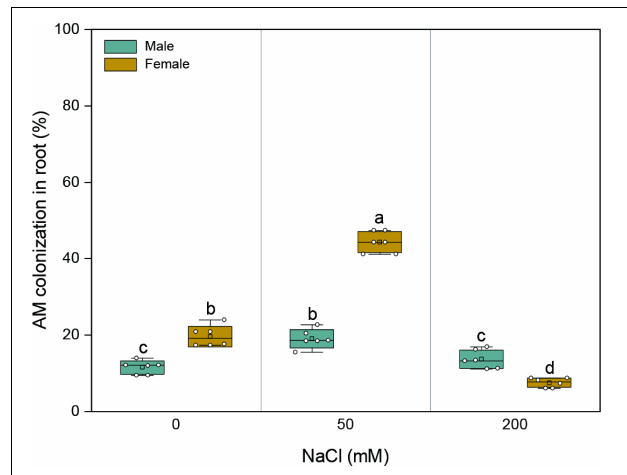
FIGURE 1 | Arbuscular mycorrhizal colonization of roots in about 7-month-old males and females of Morus alba inoculated with Funneliformis mosseae after 132 days of salinity treatment. Values are presented as means ± SD ( n = 6). Two-way ANOVA is performed to compare the effects of sex and salt and their interactions in both males and females. Different letters indicate a significant difference according to least significant difference at p <